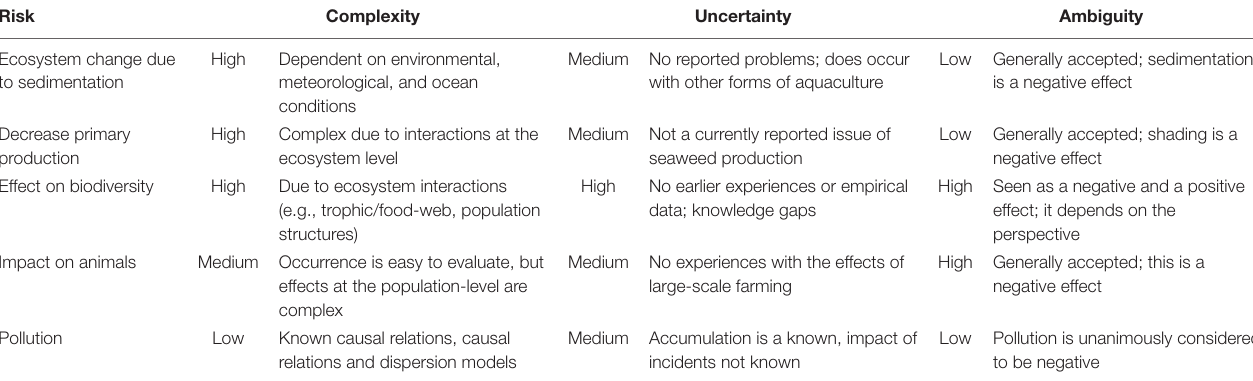
TABLE 4 | Characterization of environmental safety